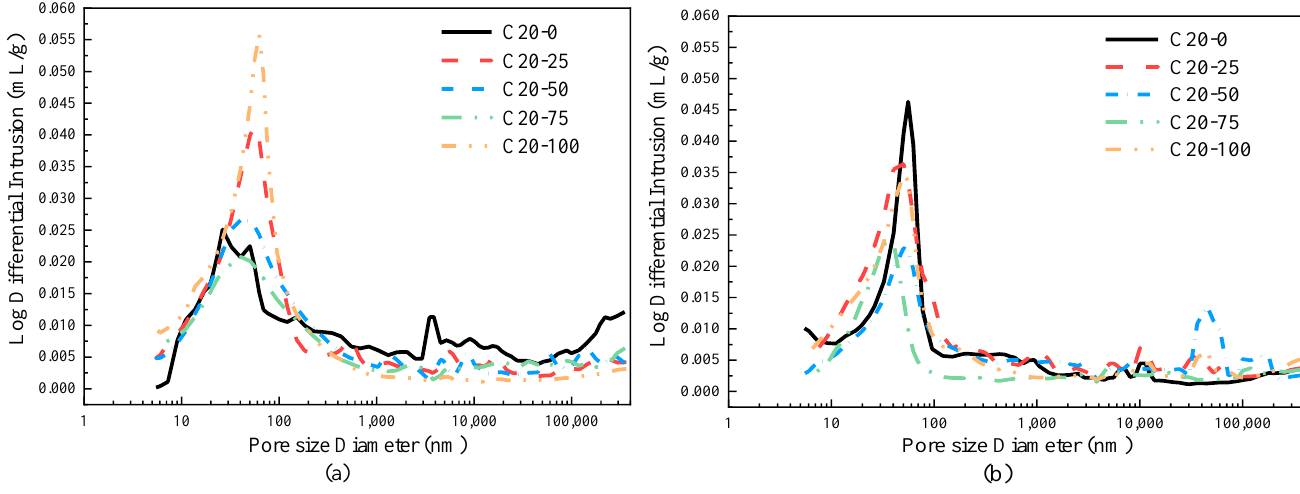
Figure 11. Pore size distribution of C20 concrete. ( a ): Curing ages (7 days); ( b ): Curing ages (28 days).